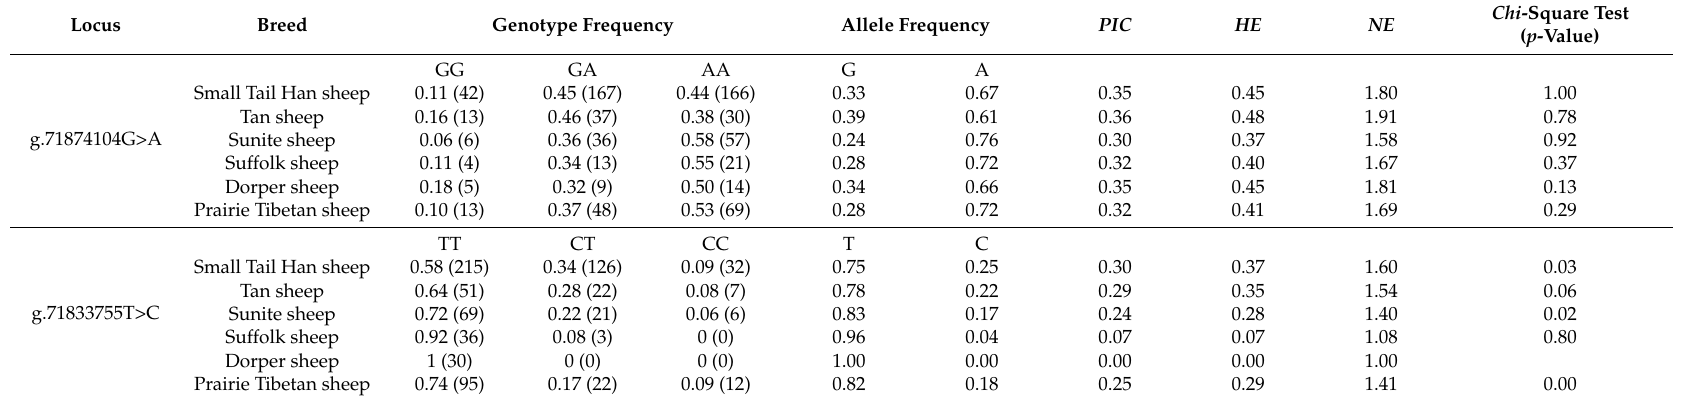
Table 3. Population genetic analysis of g.71874104G>A and g.71833755T>C in six sheep breeds. Locus